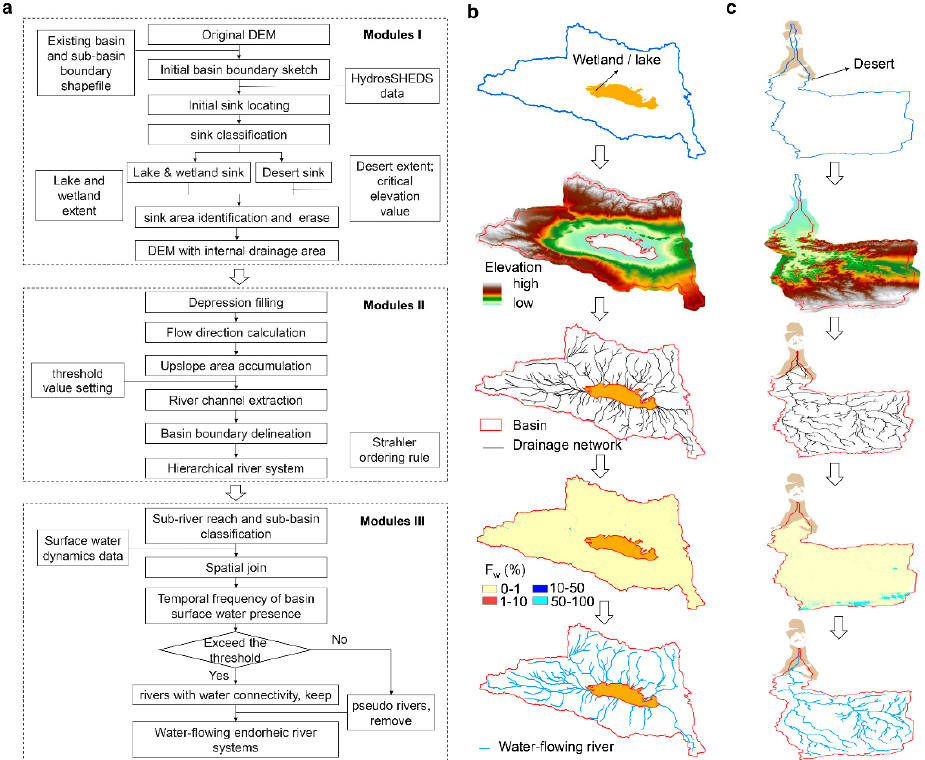
Figure 2. Identification of endorheic rivers. ( a ) The overall framework composed of three modules, i.e., introduction of internal drainage areas (Module I), extraction of river networks and delineation of basin boundaries (Module II), and identification of flowing rivers (Module III). ( b , c ) Separately represent two cases about the workflows on identification of endorheic rivers with a wet/lake sink and with a desert sink.